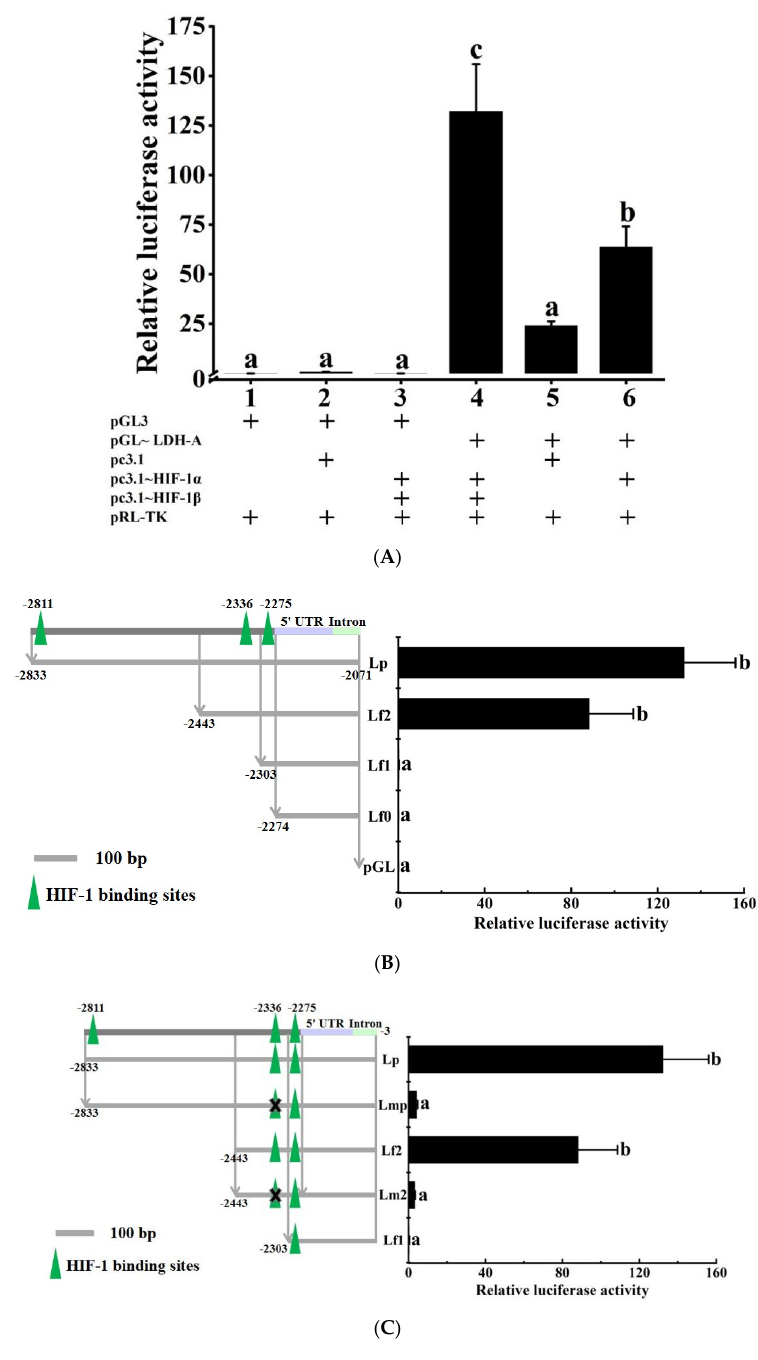
Figure 9. The regulatory relationship of transcription factor HIF-1 on the LDH-A gene in the dual- luciferase reporter assay. ( A ) Transcription factor HIF-1 transcriptionally regulates the LDH-A gene. The pGL3 and pc3.1 represent circular pGL3-Basic plasmid and circular pcDNA3.1 (+) plasmid, respectively, which are not linked to the exogenous sequence. Reporter plasmid pGL~LDH-A was constructed using the LDH-A gene promoter sequence and fragmented pGL3-Basic plasmid digested by double endonuclease (SacI and HindIII). Expression plasmid pc3.1~HIF-1 α was constructed using the HIF-1 α CDS sequence and fragmented pcDNA3.1 (+) digested by single endonuclease (BamHI). Expression plasmid pc3.1~HIF-1 β was constructed using the same method. PRL-TK is the control plasmid expressing Renilla luciferase (Rluc) to characterize the transfection efficiency. Arabic numerals of abscissa in Figure 9A indicate different treatment groups. ( B ) The fragmentation deletion result.